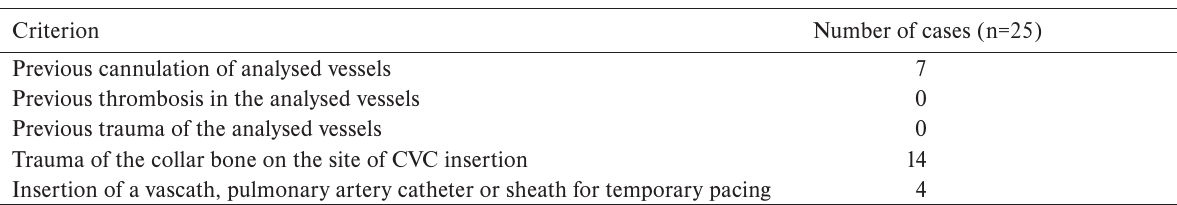
Table 3. Exclusion criteria.